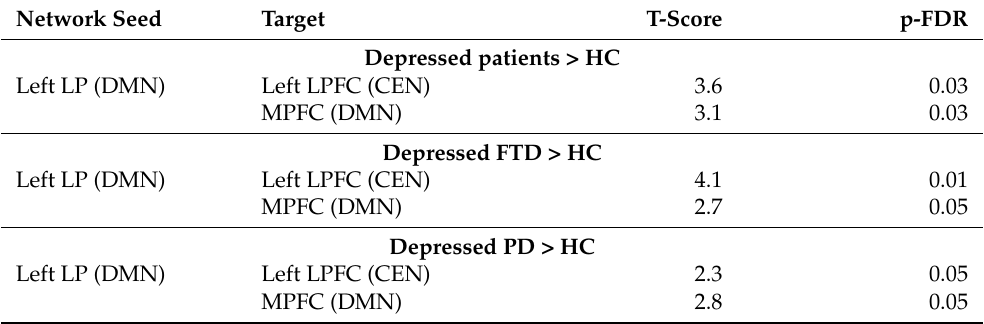
Table 3. Resting-state fMRI network-to-network findings between depressed patients and HC group and between depressed FTD and PD patients and HC (higher connectivity between seeds have a positive value of T-score; LP: lateral parietal lobule; DMN: default-mode network; LPFC: lateral prefrontal cortex; CEN: central executive network; MPFC: medial prefrontal cortex; p-FDR: p -value corrected for false discovery